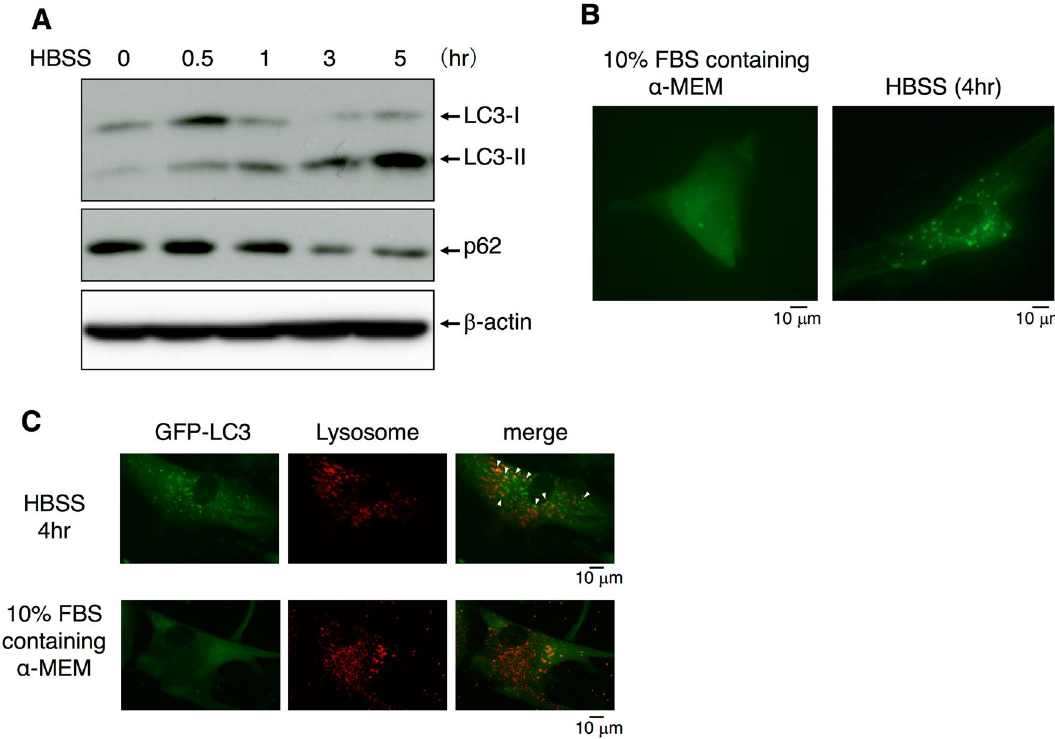
Figure 2. Autophagosome formation is stimulated by nutrient deprivation in human periodontal ligament (HPDL) cells. ( A ) Western blotting analysis of LC3 and p62 in HPDL cells. HPDL cells were treated with no-serum Hank’s balanced saline solution (HBSS) for the indicated period. Upper bands indicate LC3-I and lower bands indicate LC3-II for LC3 blotting. Full length blots are presented in Supplementary Fig. S5. ( B ) GFP-LC3-transduced HPDL cells were treated with no-serum HBSS for 4 h. LC3 dot formation was detected by phase-contrast fluorescence microscopy. ( C ) Localisation of LC3 was determined by confocal microscopy with lysosome labelled GFP-LC3 transduced HPDL cells. HPDL cells were treated with no-serum HBSS for 4 h. Lysosomes were labelled with Lysotracker (red) Arrow indicates the localisation of LC3 in lysosomes. Representative data from three independent experiments are